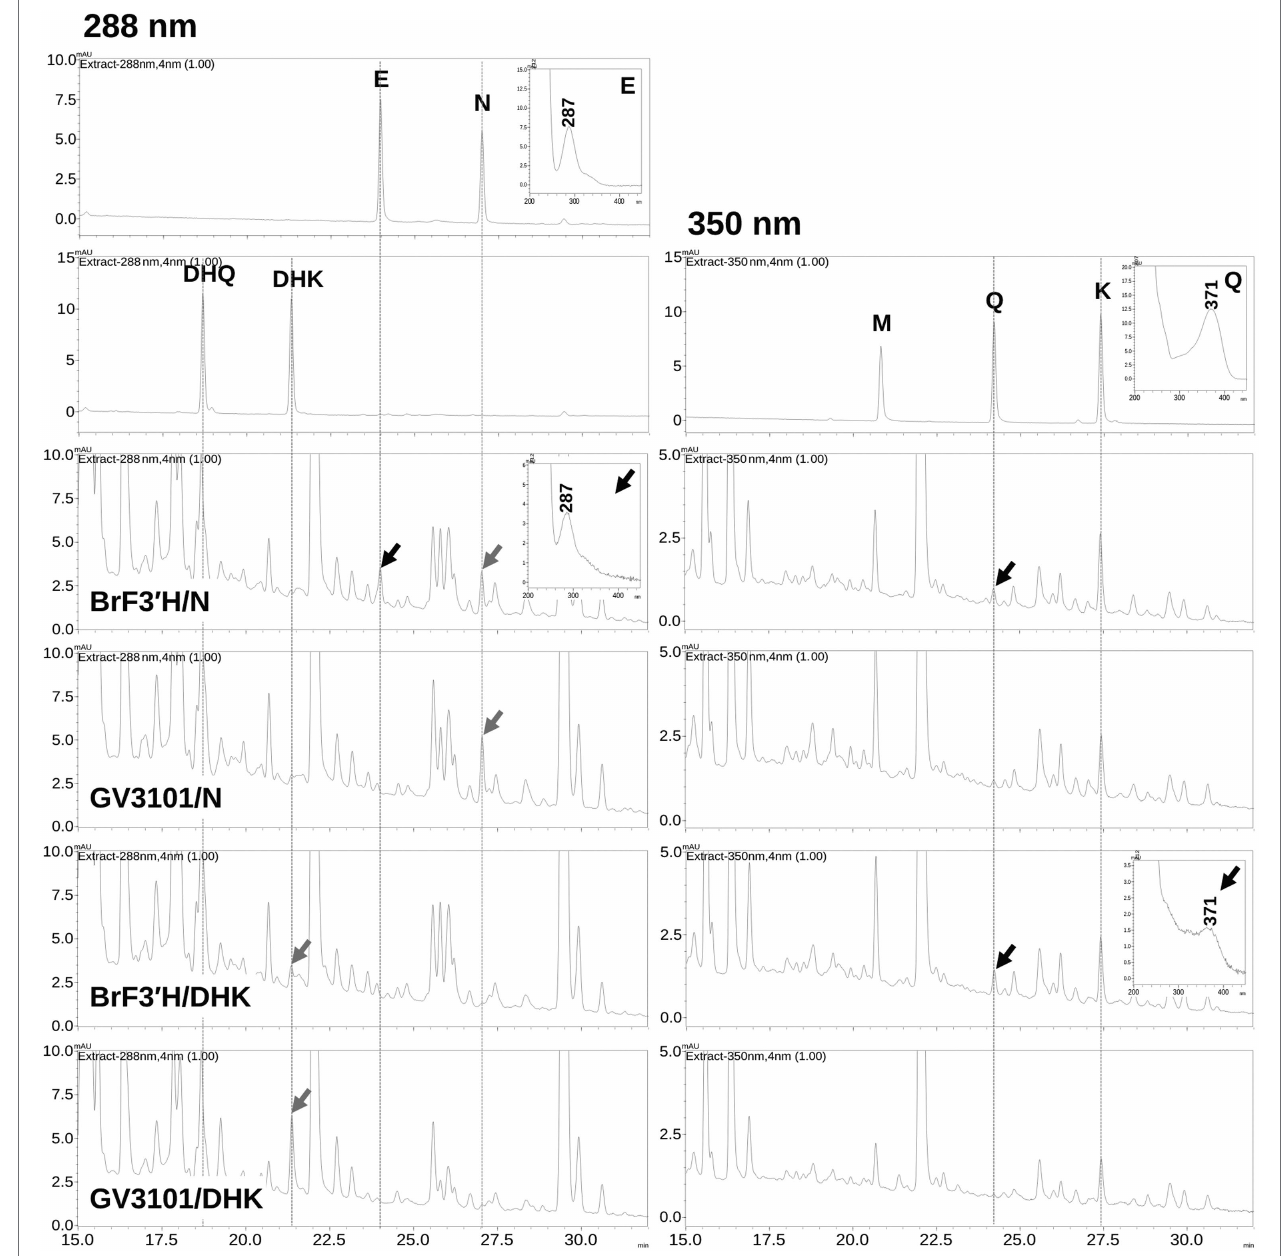
FIGURE 7 | Production of 3 ′ -hydroxylated flavonoids in N. benthamiana leaves by transient expression of Br F3 ′ H-8267. N. benthamiana leaves were agro-infiltrated with GV3101 strain harboring Br F3 ′ H-8267, and substrates (N, naringenin; DHK, dihydrokaempferol) were infiltrated into the same leaves 4 days after the initial agro- infiltration of Br F3 ′ H and incubated for 24 h. GV3101/N and GV3101/DHK refer to leaves agro-infiltrated with the empty strain GV3101 as negative control and infiltrated with substrates (N or DHK) 4 days after the initial agro-infiltration. The leaves were extracted with acidic alcohol to generate flavonoid aglycones, and the extracts were analyzed using HPLC. Peaks were detected at 288 nm for flavanones (E, eriodictyol; N, naringenin) and dihydroflavonols (DHQ and DHK) and at 350 nm for flavonols (M, myricetin; Q, quercetin; K, kaempferol). The peaks were identified by comparing relative retention times and UV spectra to the standards, and peaks corresponding to the infiltrated substrates are indicated by black arrows and corresponding to 3 ′ -hydroxylated flavonoids produced by the transient expression of Br F3 ′ H-8267 are indicated by red